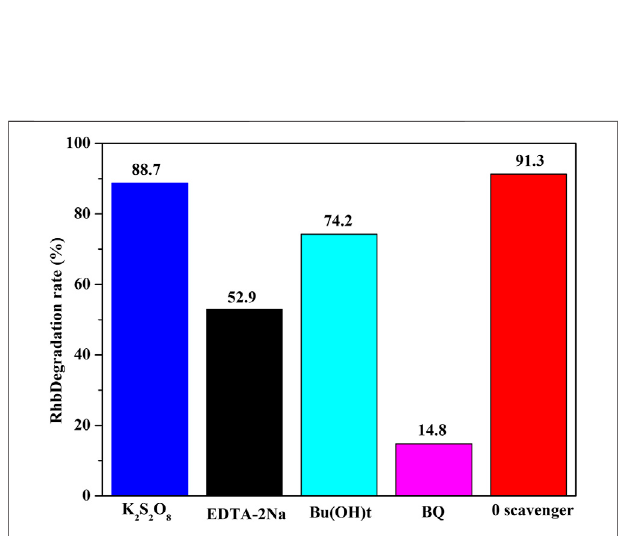
FIGURE 8 | Photocatalytic degradation of MO by NH 2 -Phen/TiO 2 in the presence of different capture agents under visible light (70 mg catalysts and 70 ml MO solution with a concentration of 10 mg/L).